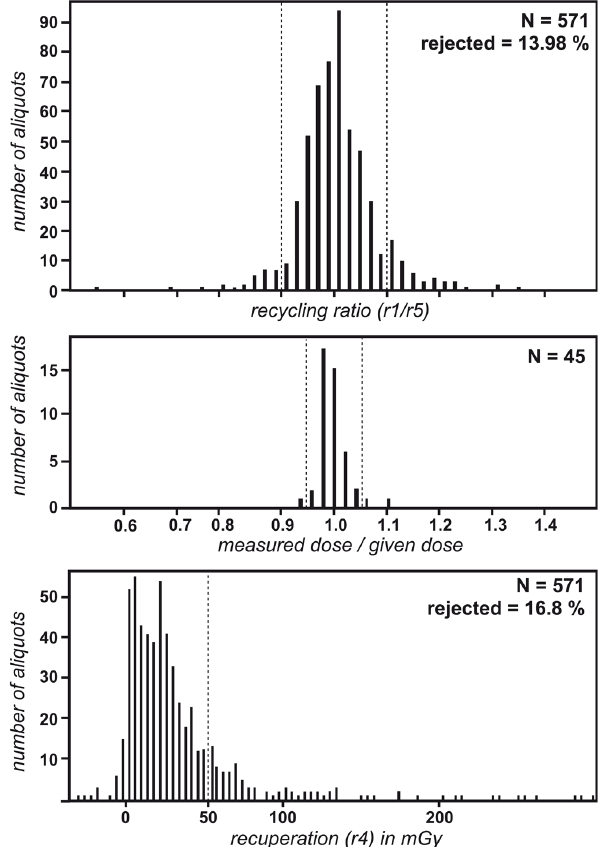
Fig. 7. Summary of recycling ratio, dose recovery and recupera- tion data of all samples. The dotted lines mark the limits of the acceptance criteria (recycling ratio: 0.9–1.1, dose recovery: 0.95– 1.05, recuperation: ≤ 50mGy). Only 14% of all measured aliquots (N) were rejected because of their recycling ratio and 16.8% due to their recuperation. Mean dose recovery values (computed from 4–5 aliquots per sample) all matched the acceptance